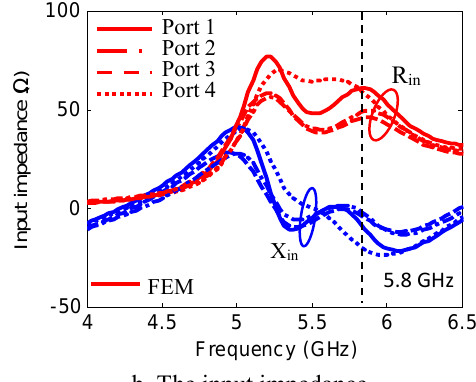
Fig.11. The reflection coefficient and the input impedance of the 2×2 circularly polarized DRA array elements mounted on a cylindrical ground plane in free space.